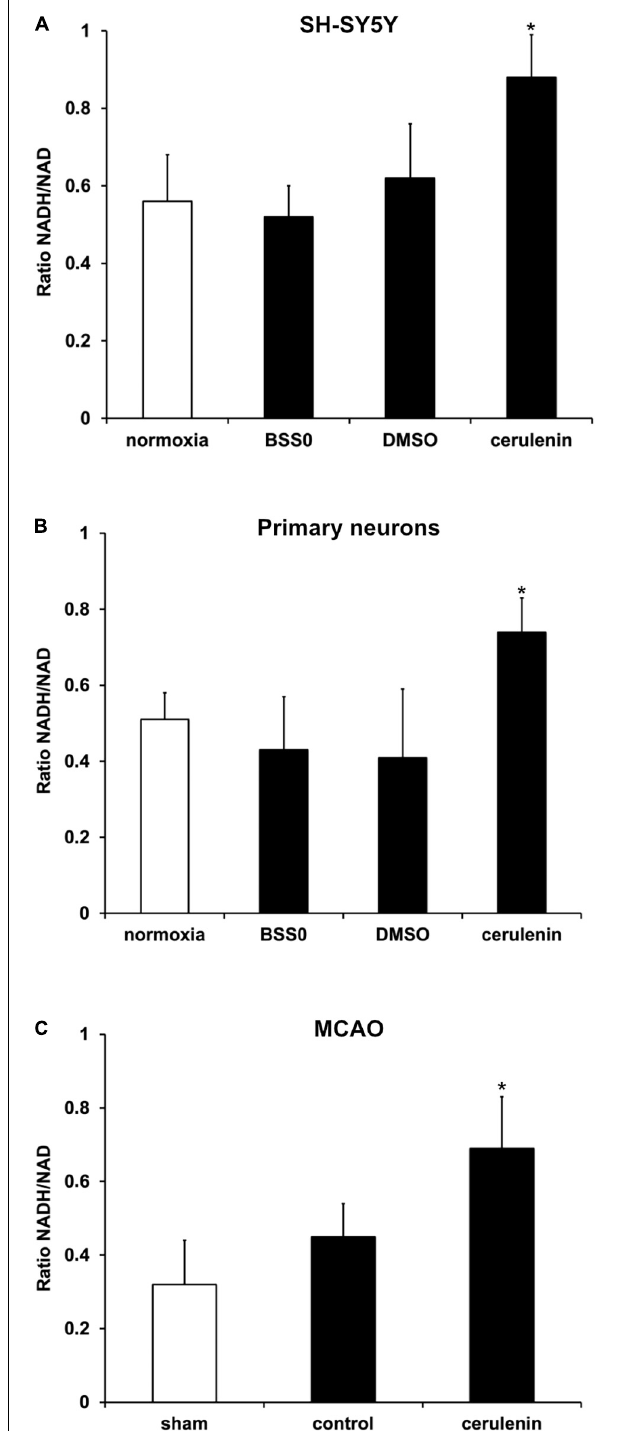
FIGURE 4 | Reduction potential is reduced by inhibition of FAS in SH-SY5Y cells, primary neurons and stroke mice. (A) Cultivated SH-SY5Y cells and (B) primary cortex cells were exposed to oxygen-glucose-deprivation (OGD) in BSS0 solution for 10 h followed by reoxygenation for 24 h under standard cell culture conditions ( n = 4 per condition). The cells were either treated with